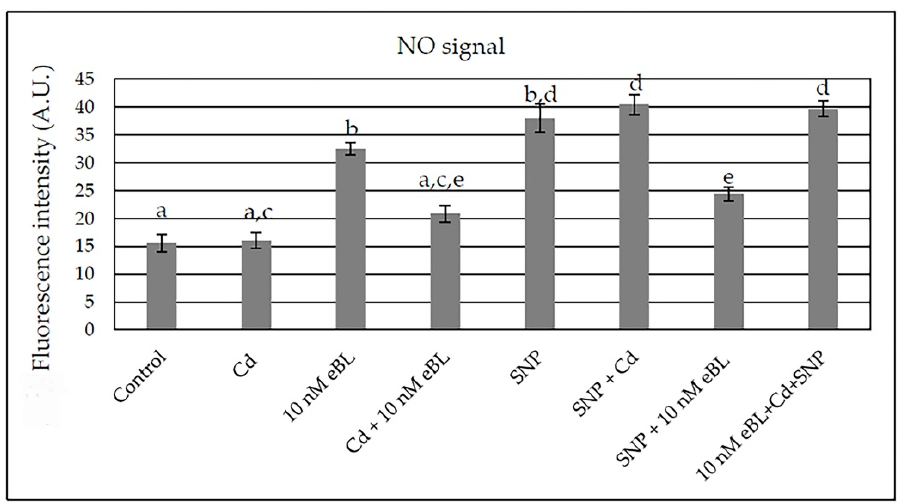
Figure 9. Mean values of nitric oxide (NO) fluorescence intensity (±SE) in Arbitrary Units (A.U.s) in root apices of Col seedlings incubated with DAF ‐ FM DA after culture for 9 days under continuous darkness followed by 7 days under 16 h light/8 h darkness photoperiod on ½ MS medium (see Sec ‐ tion 4) (Control treatment), or on the same medium plus either 60 μ M CdSO 4 (Cd) or 10 nM eBL, or Cd + 10 nM eBL, or 50 μ M SNP (SNP), or 50 μ M SNP + 60 μ M Cd (SNP + Cd), or 50 μ M SNP + 10 nM eBL (SNP + 10 nM eBL), or 10 nM eBL + 60 μ M CdSO 4 + 50 μ M SNP (10 nM eBL + Cd + SNP). Different letters show significant differences for at least p < 0.05. Columns followed by the same letters are not significantly different. n = 30. Data from the first replicate.